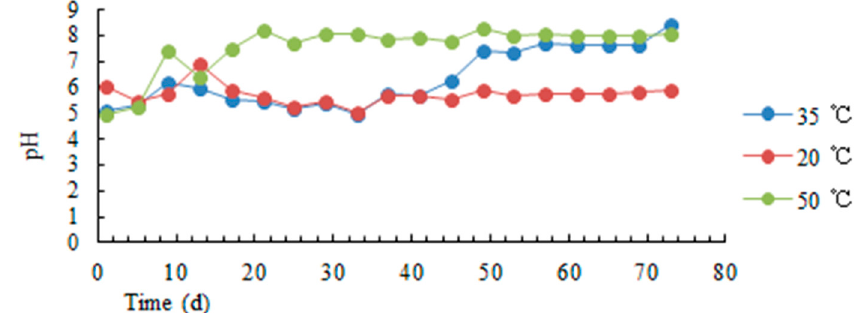
Figure 4. The change in pH at different temperatures.